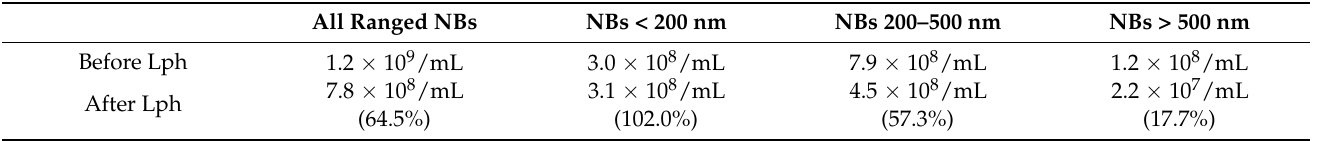
Figure A1. Temperature alterations in 0.06% human serum albumin aqueous solution during bubbling. The room temperature at the time of measurement was 18.9 °C. Grayed area: vibrational process. Table A1. Changes in nanobubble concentration with lyophilization.